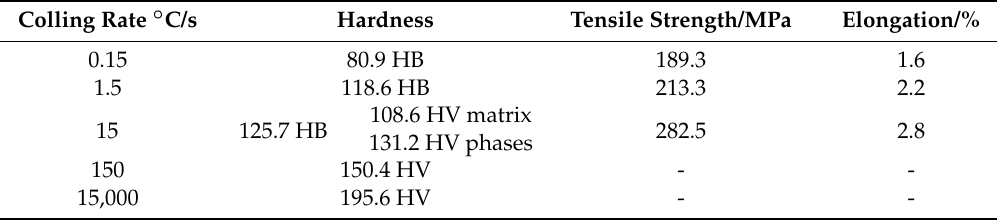
Table 4. Mechanical properties of the cast model alloy solidified with different cooling rates. Colling Rate °C/s